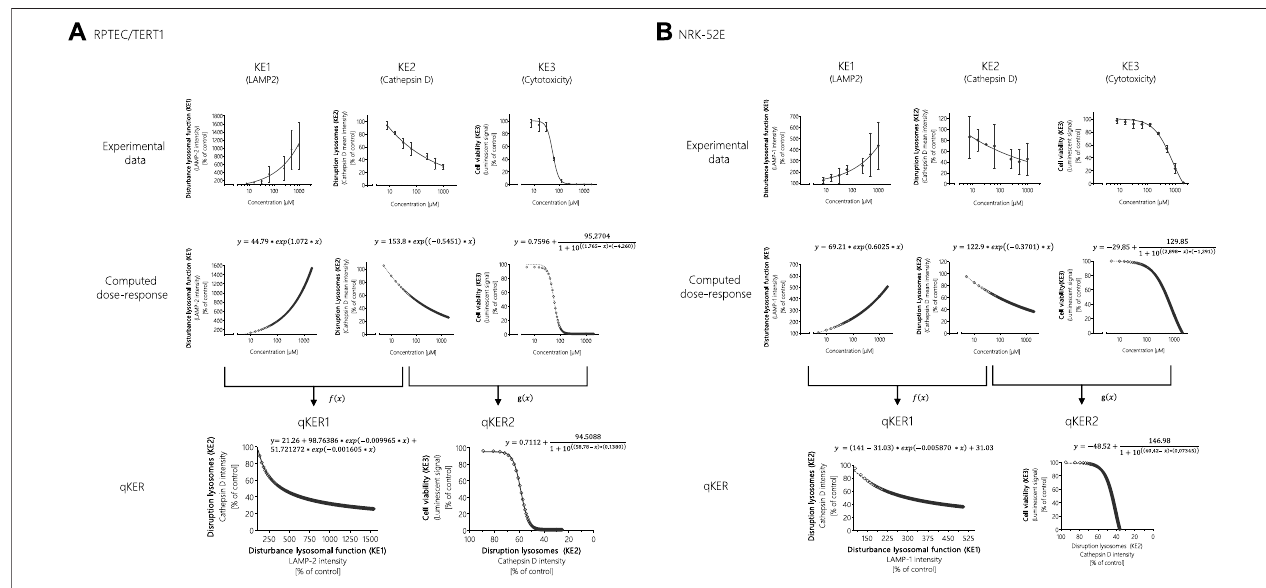
FIGURE 7 | Response-response analysis of polymyxin B KE data obtained in RPTEC/TERT1 (A) and NRK-52E (B) cells. Based on experimental in vitro data on KE1 (LAMP-1/2 intensity), KE2 (cathepsin D intensity), and KE3 (cell viability), additional data points were computed to establish quantitative KER. To this end, KE2 was plotted as a function of KE1 ( f(x) ), while KE3 was plotted as a function of KE2 ( g(x) ).